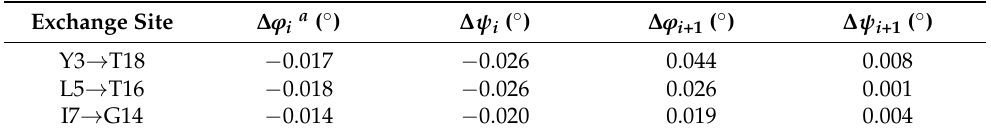
Table 2. Predicted changes of backbone ϕ and ψ dihedral angles of residues in β 2 caused by the backbone amide H/D exchange in β 1.